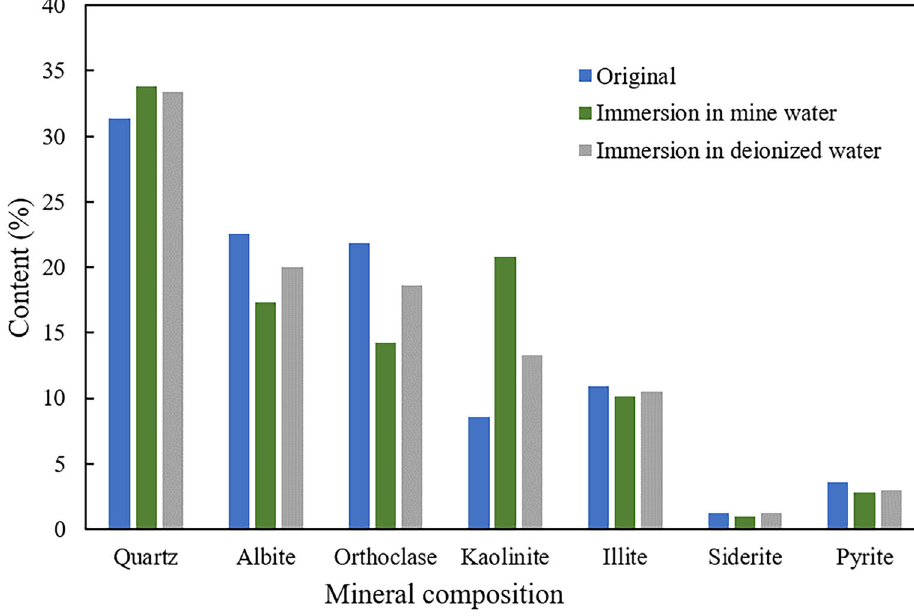
Fig. 8 The changes of mineral content in sandstone after the